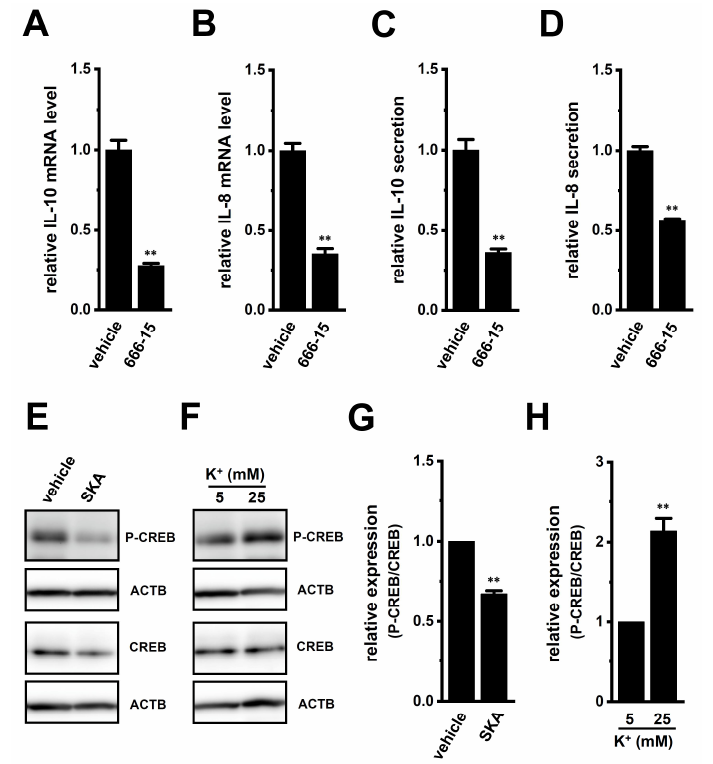
Figure 9. Effects of treatment with a CREB inhibitor on expression levels of IL-10, IL-8, VEGF-A, and TGF- β 1 transcripts and on phosphorylated P-CREB protein levels following the SKA-121 treatment and high [K + ] e exposure in THP-1-derived M 2 macrophages. ( A – D ): Real-time PCR examination of IL-10 ( A ), IL-8 ( B ), VEGF-A ( C ), and TGF-β1 ( D ) expression in THP-1-derived M 2 macrophages treated with vehicle and 1 μM 666-15 for 24 h . Relative mRNA expression in the vehicle control is expressed as 1.0 (n = 4 for each). E-F: Western blot showing P-CREB and total CREB (CREB) in 1 μM SKA-121-treated ( E ) and high [K + ] e -exposed ( F ) THP-1-derived M 2 macrophages. Specific band signals for P-CREB and CREB were observed at approximately 40 kDa. G, H: Summarized results of the relative protein expression of P-CREB/CREB in 1 μM SKA-121-treated ( G ) and high [K + ] e -exposed ( H ) THP-1-derived M 2 macrophages. After compensation with the optical density of the ACTB signal, the expression level in the vehicle control or 5 mM K + is expressed as 1.0 (n = 4 for each). **: p < 0.01 vs. the vehicle control or 5 mM K + .